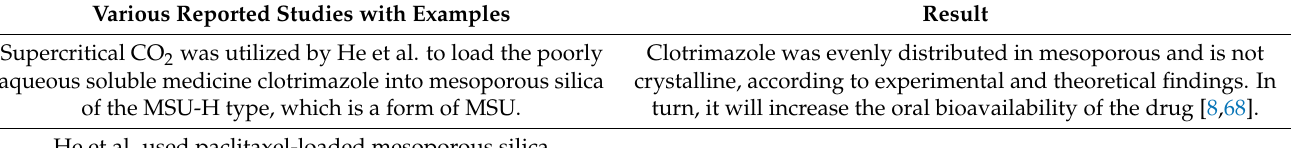
Table 1. Reported studies of msn for oral drug